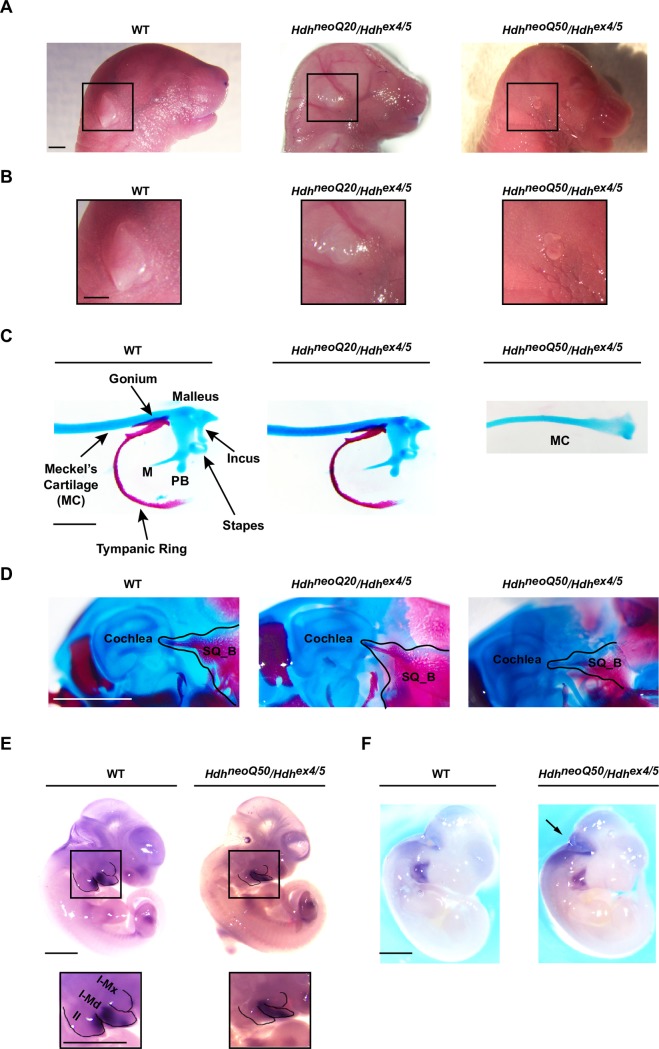
External and middle ear defects in HdhneoQ20/Hdhex4/5 and HdhneoQ50/Hdhex4/5 hypomorphic embryos.A) Representative images of wild-type (WT), HdhneoQ20/Hdhex4/5 and HdhneoQ50/Hdhex4/5 heads, showing altered morphology of external ear in HdhneoQ20/Hdhex4/5 and HdhneoQ50/Hdhex4/5 animals at E18.5. B) The region of the external ear is enlarged from (A) for each genotype, showing mis-shapen or missing external ears for the HdhneoQ20/Hdhex4/5 and HdhneoQ50/Hdhex4/5 animals. C) Representative images of alcian blue and alizarin red-stained middle ear preparations from wild-type (WT), HdhneoQ20/Hdhex4/5 and HdhneoQ50/Hdhex4/5 E18.5 embryos, showing severely altered middle ossicles in HdhneoQ50/Hdhex4/5 animals. Middle ear ossicles are indicated in the WT preparation: M = manubrium, PB = processus brevis. In HdhneoQ50/Hdhex4/5 animals, all the middle ear ossicles were absent, only the Meckel’s Cartilage (MC) was observed. D) Representative images of alcian blue and alizarin red-stained middle ear preparations from wild-type (WT), HdhneoQ20/Hdhex4/5 and HdhneoQ50/Hdhex4/5 E18.5 animals, showing hypoplastic squamous bone (SQ_B) in HdhneoQ20/Hdhex4/5 and HdhneoQ50/Hdhex4/5 animals. Black line delineates the squamosal bone. E) Whole mount in situ hybridization representative images showing altered Gsc mRNA localization in HdhneoQ50/Hdhex4/5 embryos at E11.5. The inset shows an enlarged view of the pharyngeal arches with Gsc transcript staining localized in the I-md and II arch in WT, but only localized in the first arch in HdhneoQ50/Hdhex4/5 embryos. Abbreviations: I-md = mandibular process of pharyngeal arch 1; I-mx = maxillary process of pharyngeal arch 1; II = pharyngeal arch 2. Dashed lines delineate pharyngeal arches. F) Whole mount in situ hybridization representative images showing altered Hoxa2 mRNA localization in HdhneoQ50/Hdhex4/5 embryos at E11.5. The arrows indicate ectopic expression of Hoxa2 transcript in the dorsal area of HdhneoQ50/Hdhex4/5 embryos. Scale bars, 1.5 mm for A-B; 400 μm for C-D; 1.5 mm for E-F.